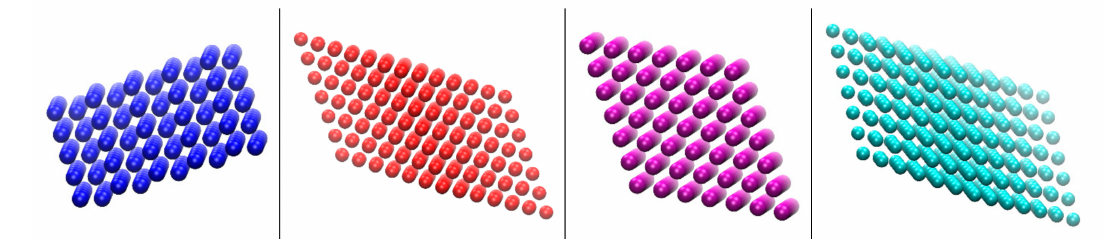
Figure 1. Reference 3-D crystals used for the demonstration of the Characteristic Crystallographic Element (CCE) descriptor. From left to right: hexagonal close packed (HCP), face centered cubic (FCC), hexagonal (HEX) and body centered cubic (BCC) lattices. Color convention according to which HCP, FCC, non-crystallographic fivefold (FIV) (not shown here), HEX and BCC sites are represented in